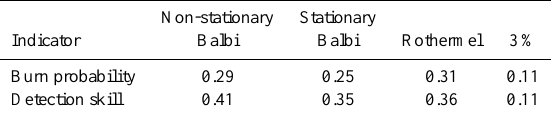
Figure 5. Case of the Santo Pietro di Tenda fire (1 July 2003; B0 in Fig. 5. Case of Santo Pietro di Tenda fire (2003-07-01, B0 in appendix) as observed (burned area in the Appendix) as observed (burned area in grey) and simulated by grey) and simulated by the non-stationary Balbi model (blue), the stationary Balbi model (green), the non-stationary Balbi model (blue), the stationary Balbi model the Rothermel model (black) and the 3-percent model (cyan). (green), the Rothermel model (black) and the 3% model (cyan). Table 3. Burn probability and detection skill for the four models, all fires included. The burn probability is the frequency with which the model correctly predicts that a location will be burned in reality. The detection skill is the frequency with which a burned location (in observations) is also burned in the